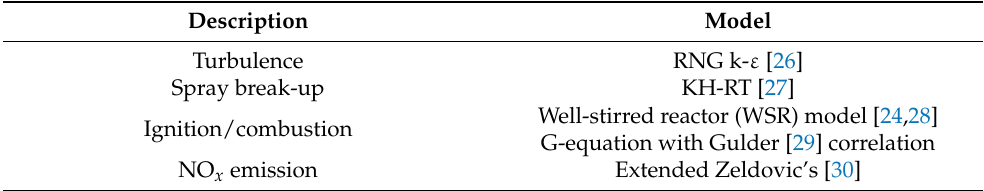
Table 3. CFD sub-model setup.